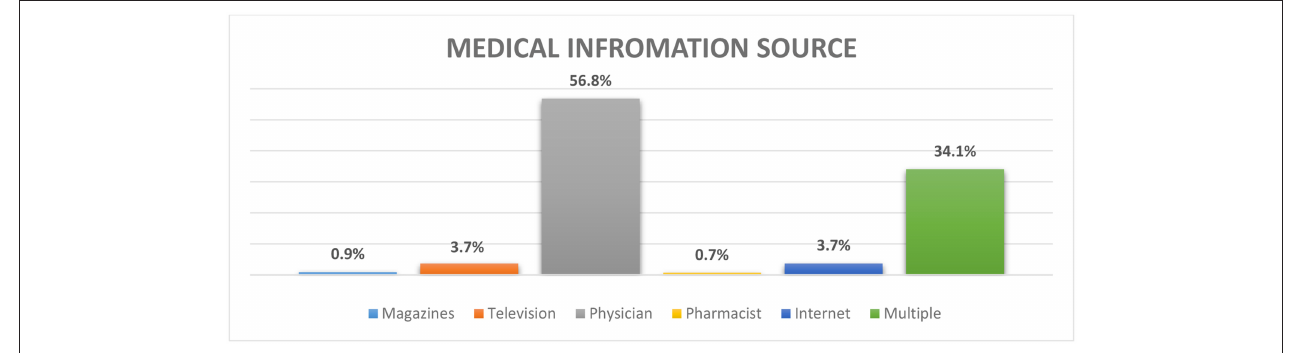
FIGURE 2 | Distribution of different sources of medical information about the disease and its treatment among our participants.